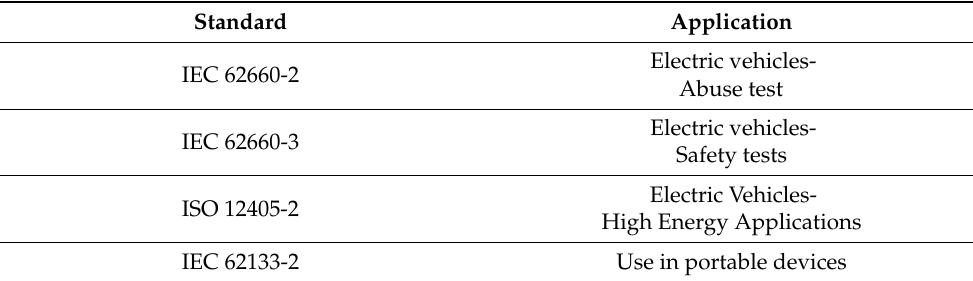
Table 1. Overview of selected standards